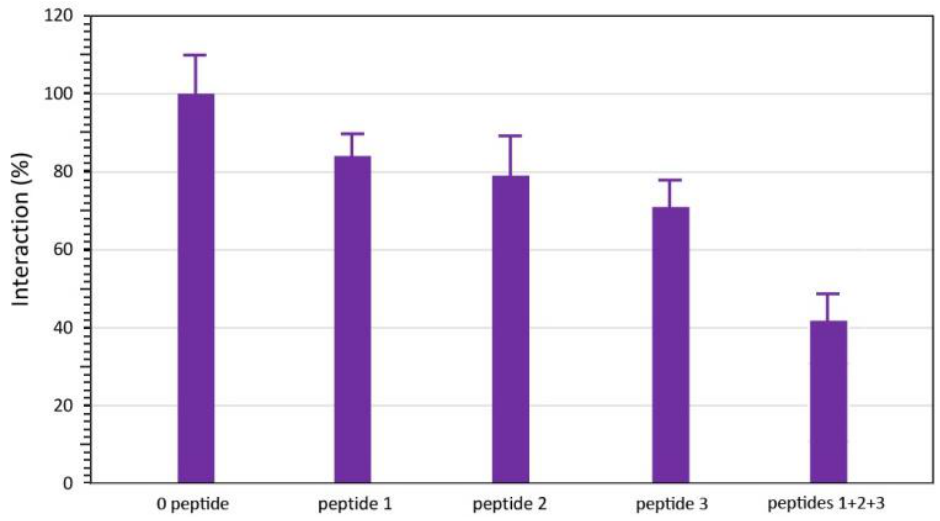
Figure 3. ELISA inhibition of the interaction between cypress pollen extract and IgE from CPAPs, in the presence of 2 mM of synthetic peptides corresponding to epitope 1 (peptide 1: 9PGGGKRLDQ27), epitope 2 (peptide 2: 45RFWGRTGIT53), epitope 3 (peptide 3: 161TNYSKIFKN169), and an equimolar mixture of the three peptides 1, 2, and 3 (peptides 1 + 2 + 3). All values are the mean ± s.d. of three separate measurements performed in the same experimental conditions.